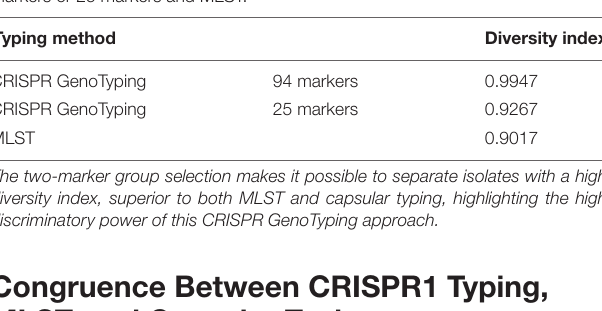
TABLE 2 | Hunter and Gaston diversity index of CRISPR typing scheme with 94 markers or 25 markers and